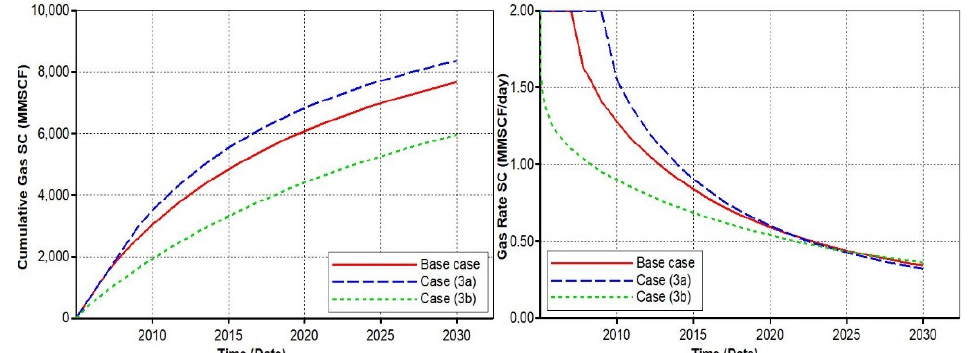
FIG. 6. EFFECT OF FRACTURE CONDUCTIVITY ON CUMULATIVE GAS PRODUCTION AND GAS RATE ON SHALE GAS